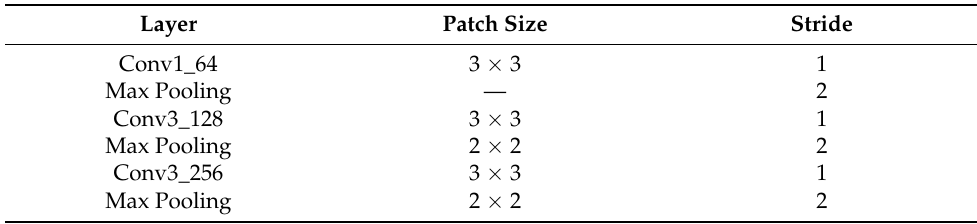
Table 2. The structures of the ResNets: the convolutional layer parameters are denoted as “Conv (receptive field size [49]) (number of channels)”; the ReLU [50] activation function is not shown for brevity.